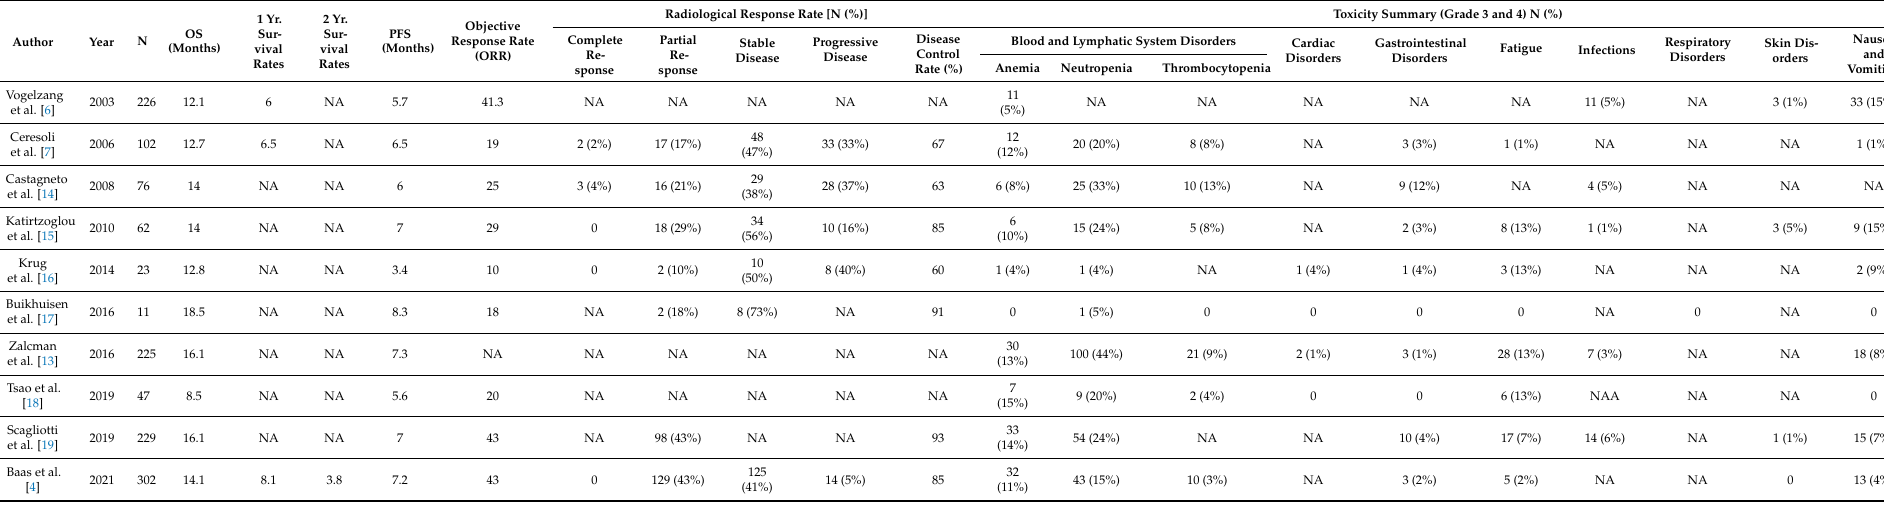
Table 2. Treatment outcomes, radiological response, and toxicity summary for malignant pleural mesothelioma patients treated with cisplatin/carboplatin and